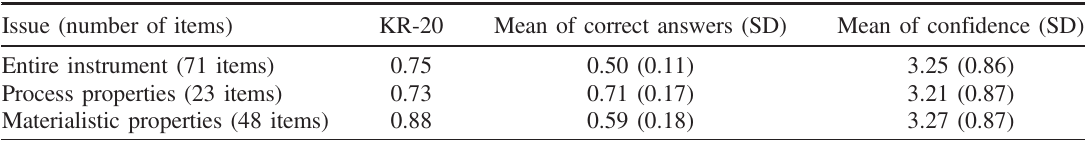
TABLE II. Mean of correct answers and confidence. Issue (number of